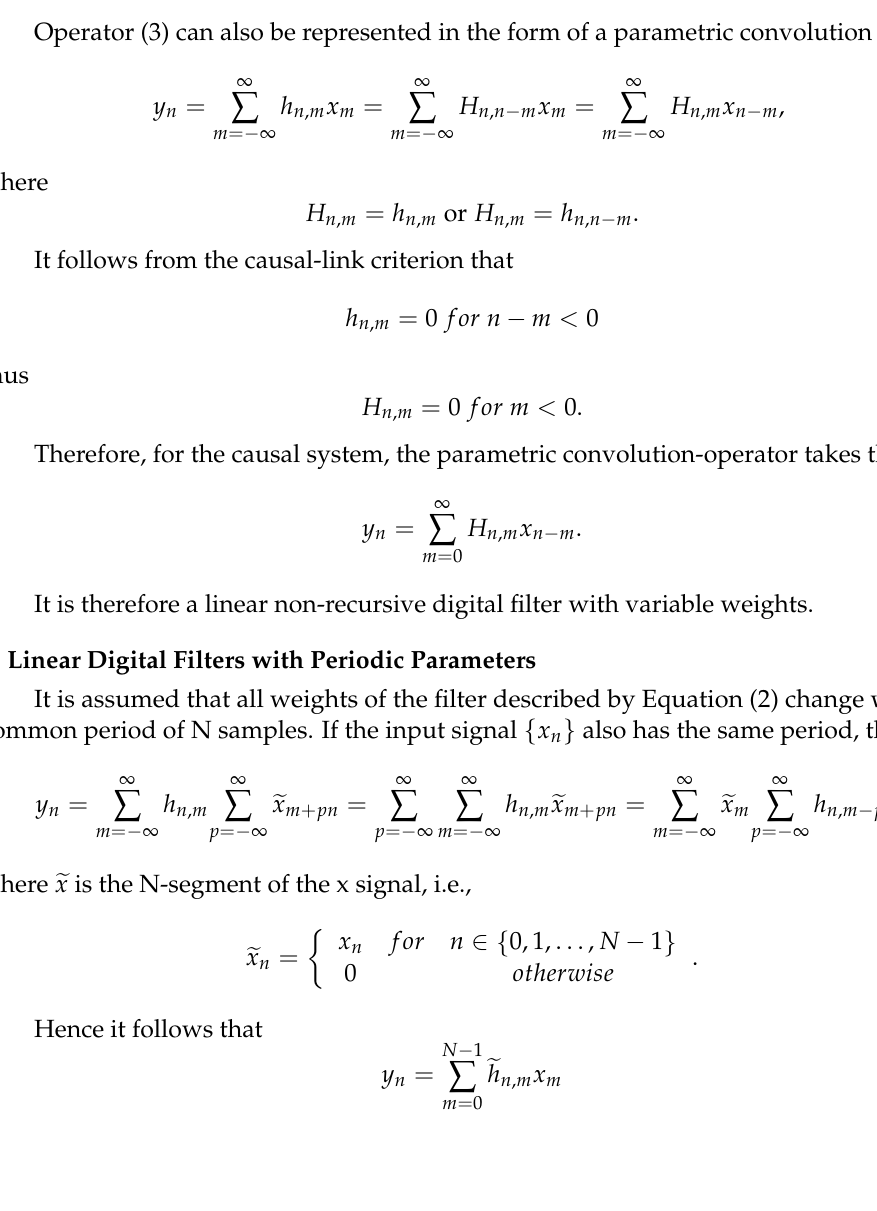
Figure 2. Illustration for determining the h n,m operator.